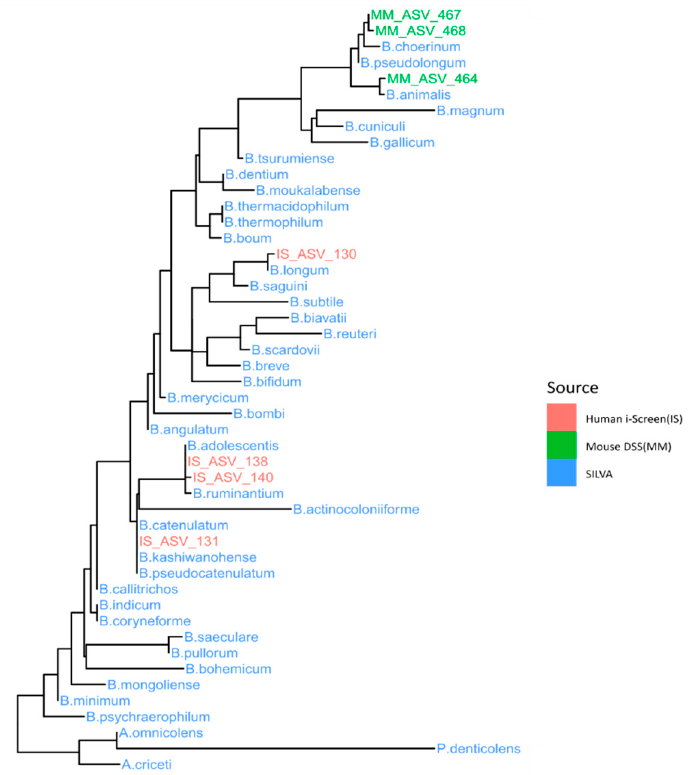
Figure 6. A phylogenetic tree showing the placement of relevant bifidobacteria lineages in mouse and human. The phylogenetic tree shows bifidobacteria lineages in human (pink) and mouse (green) and the reference SILVA database (blue).